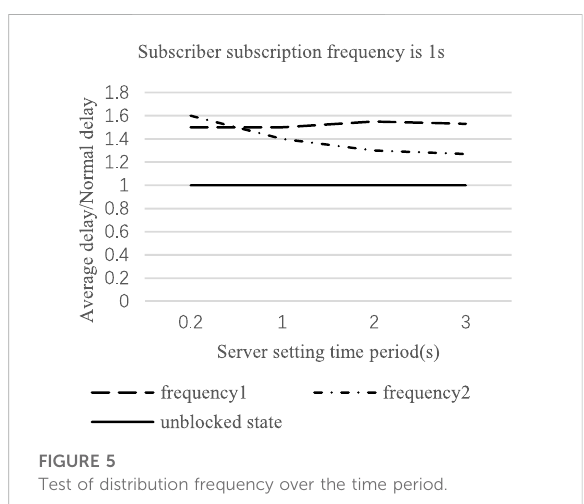
FIGURE 5 Test of distribution frequency over the time period.